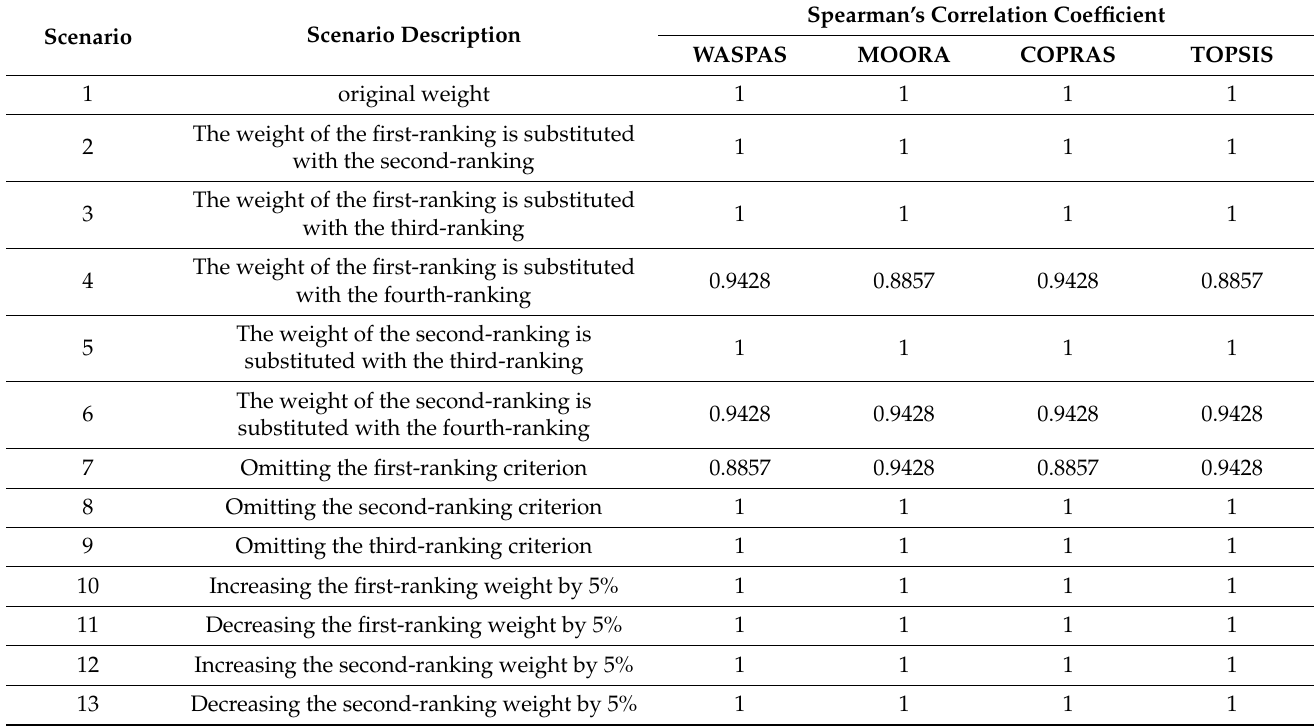
Table 5. Weighting scenarios and Spearman’s correlation coefficient values of WASPAS, MOORA, COPRAS, and TOPSIS.